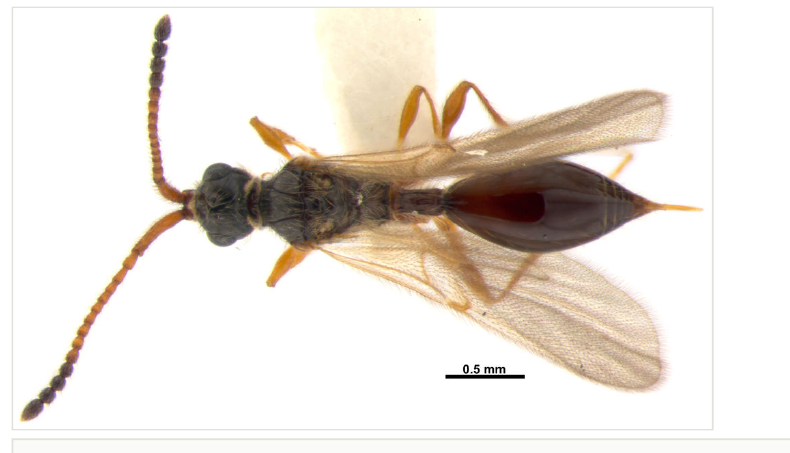
Figure 1. Acanospilus heterocerus Haliday, female. Habitus in dorsal